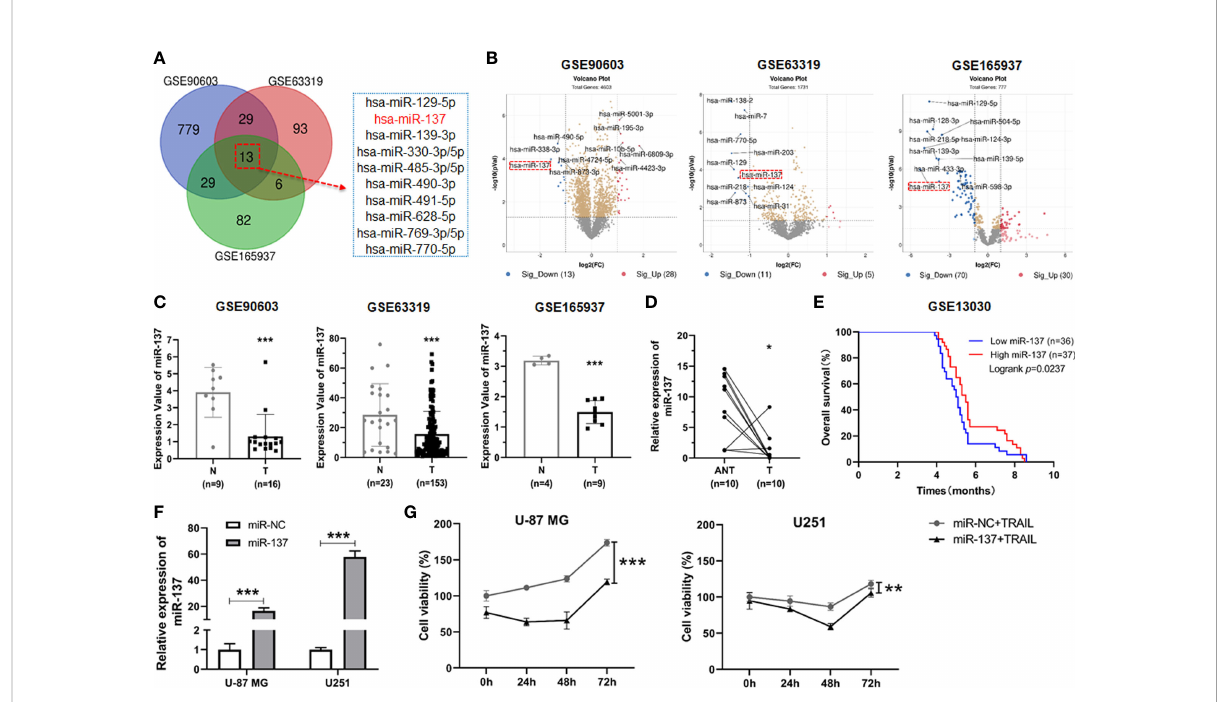
FIGURE 1 miR-137 is reduced in tumor tissues of glioblastoma patients and correlated with the survival rate in clinic. (A) Bioinformatic interrogation of Gene Expression Omnibus (GEO) datasets. The downregulated miRNAs in glioblastoma samples compared with normal brain tissues. Identify key miRNAs related to glioblastoma by combining three GEO datasets. (B) The differential expression miRNAs of GEO datasets (threshold set as | log 2 (Fold Change)| ≥ 1, P < 0.05). Here ’ s the top ten miRNAs in each GEO datasets. (C) The expression value of miR-137 in glioblastoma (T) and normal (N) tissues (GSE90603, GSE63319, GSE165937). (*** P < 0.001.) (D) Relative expression of miR-137 in carcinoma (T) and adjacent